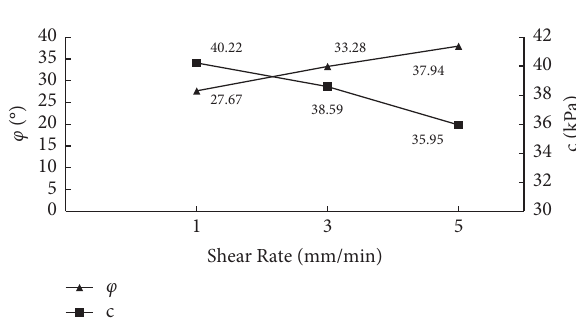
Figure 15: Variation curve of the interfacial shear strength pa- rameters under diferent shear